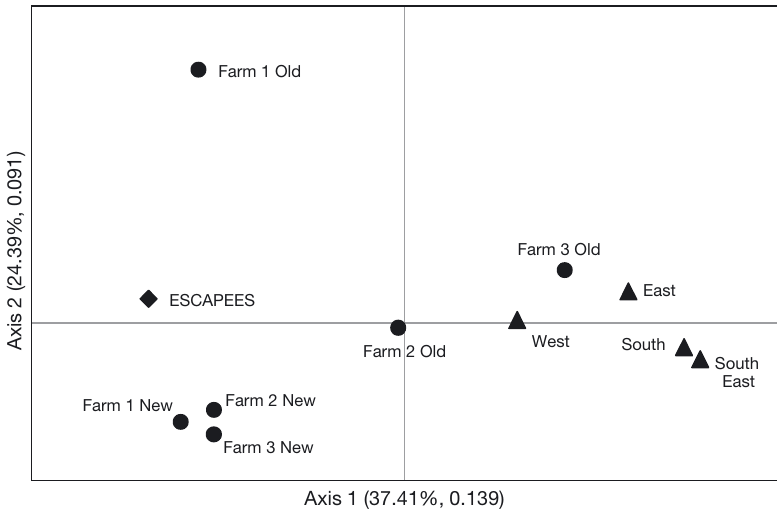
Fig. 3. Principal coordinate analysis based on the standardized covariance of Nei’s unbiased genetic distance between wild ( m ) and farmed ( d ) populations. A total of 10 samples were used per population. Axis label includes percentage of variation explained by axis and the axis